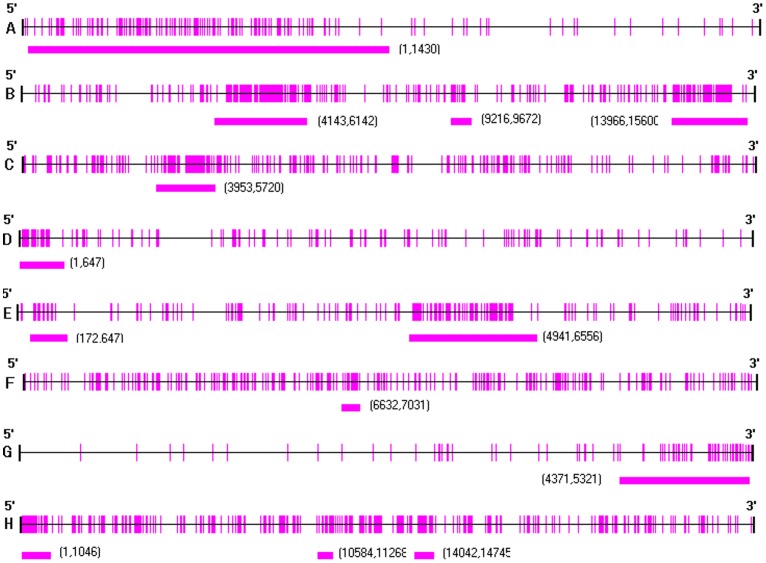
The CpG sites analyzed in promoters of APM genes family.Each vertical indicate an individual CpG site. Solid line positions of BSP primers. All the BSP primers are designed to cover the transcriptional start site should be close to transcriptional start site. Panels A-H depict HLA-B, TAP-1, TAP-2, LMP2, LMP7, Tapasin, ERAP1 and ERp57.